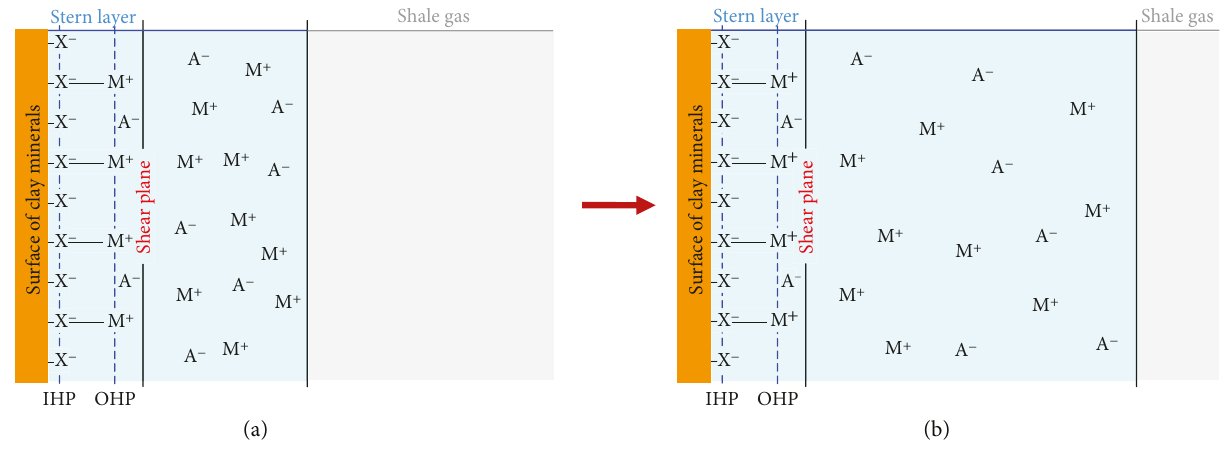
Figure 2: Sketch of the excess charge density of the pore water in di ff erent water saturations. Figure 3: Sketch of triple-layer model of the clay-water interface.